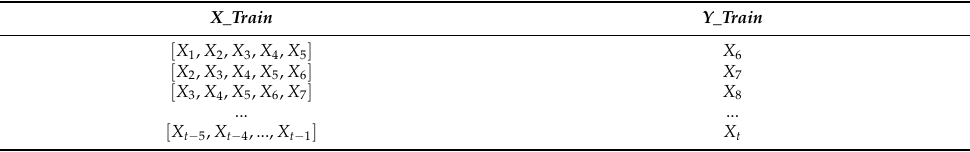
Table 3. A univariate time series converted to supervised learning.